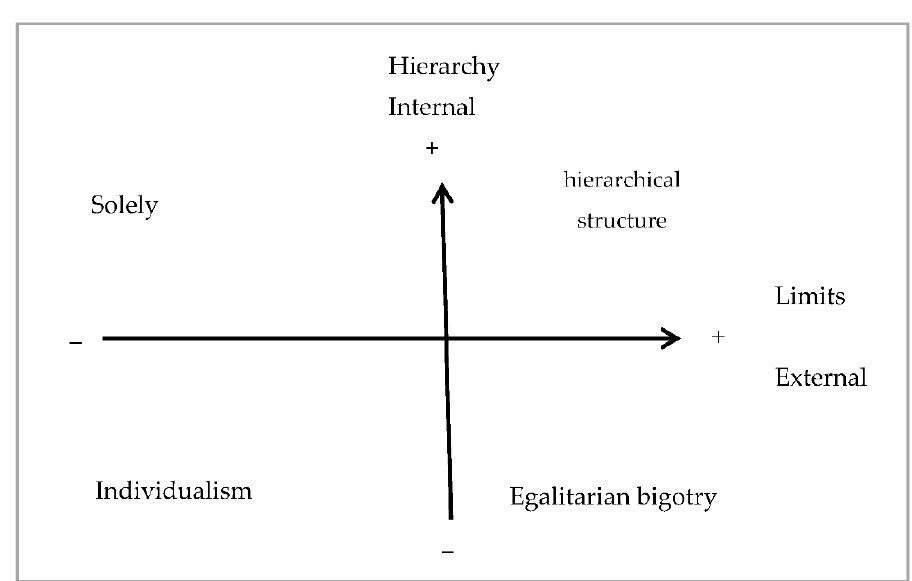
Figure 1. The matrix of “cultural theory” according to Mary Douglas.